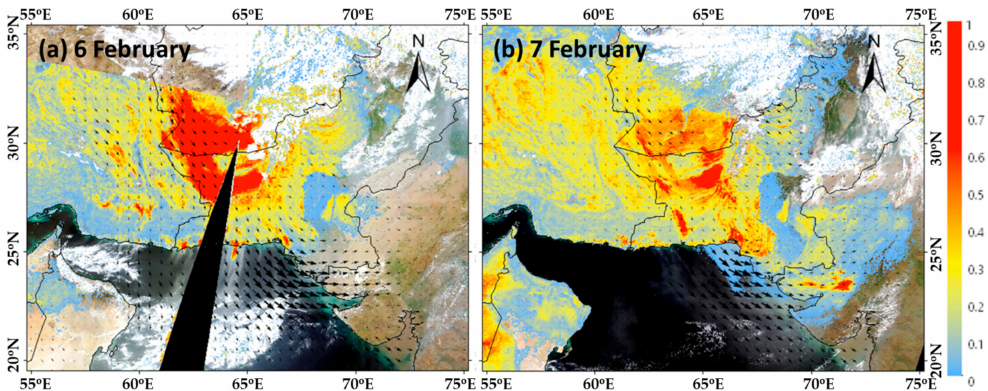
Figure 3. Spatial distribution of the brightness temperature adjusted dust index (BADI) values estimated from Terra-MODIS L1B MOD021KM retrievals superimposed by 925 hPa winds on ( a ) 6 and ( b ) 7 February